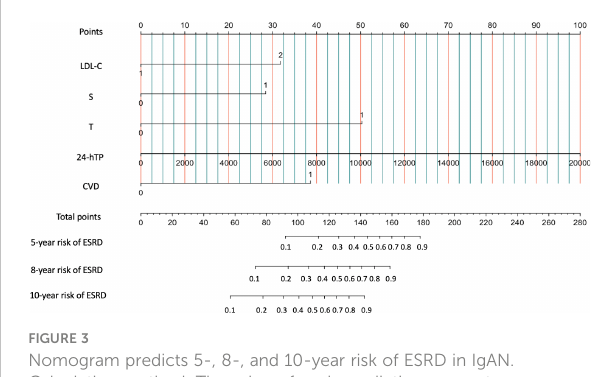
FIGURE 3 Nomogram predicts 5-, 8-, and 10-year risk of ESRD in IgAN. Calculation method: The value of each predictive parameter corresponds upward to the value on the Point axis, and then the “ Point ” values of all parameters are summed to correspond to the value on the “ total point ” axis, and downward to the 5-, 8-, and 10- year risk of ESRD in